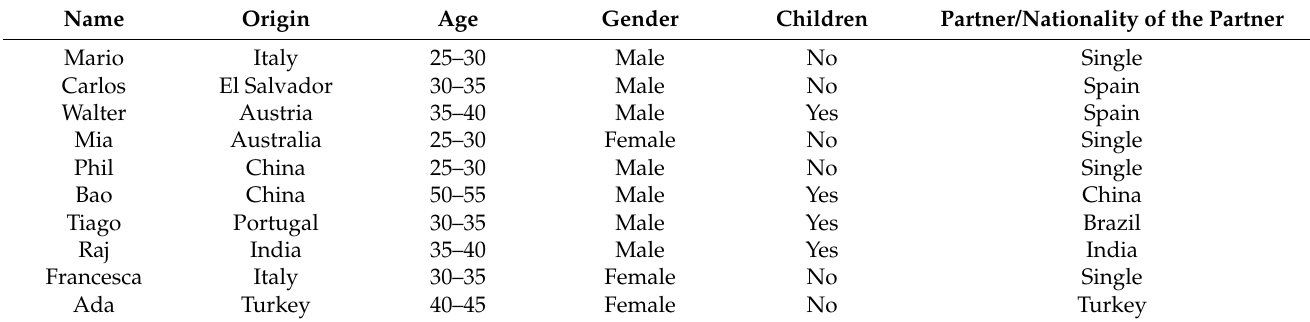
Table 2. Profiles of the interviewees: HSMs who moved for job-related